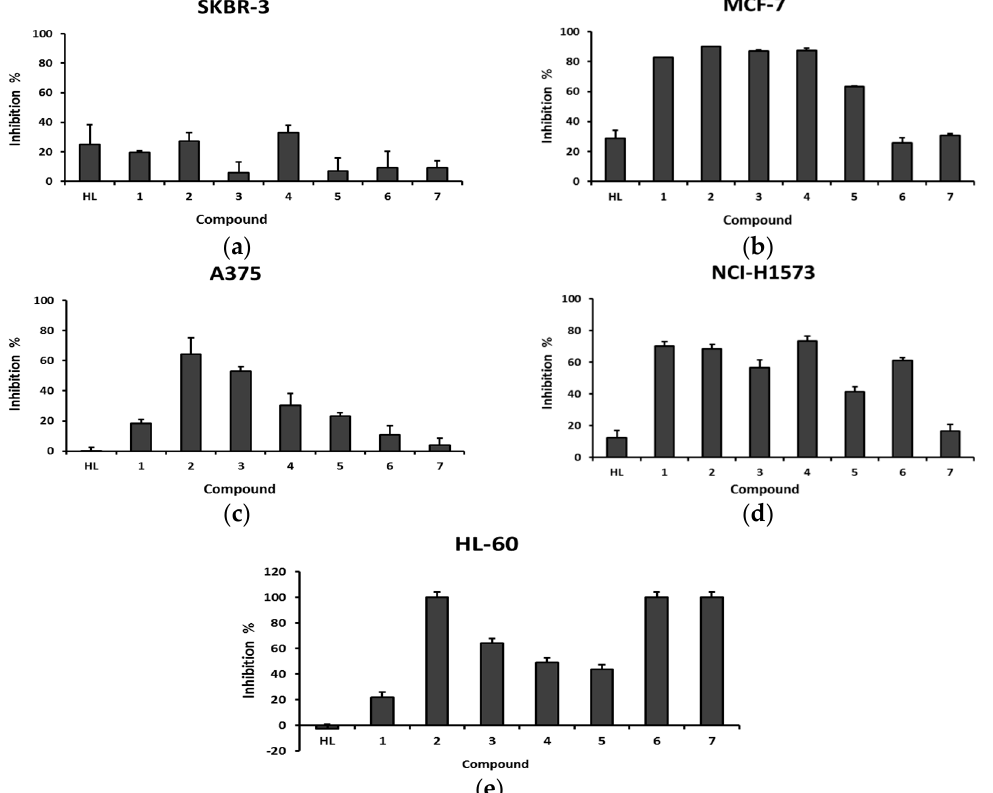
Figure 6. The effects of ligand HL and complexes 1 – 7 on SKBR-3, MCF-7, A375, NCI-H1573 and HL-60 cell proliferation. ( a ) Inhibition of cell proliferation on SKBR-3 human breast cancer cell line; ( b ) Inhibition of cell proliferation on MCF-7 human breast cancer cell line; ( c ) Inhibition of cell proliferation on A375 melanoma cell line; ( d ) Inhibition of cell proliferation on NCI-H1573 lung adenocarcinoma cell line; ( e ) Inhibition of cell proliferation on human leukemia HL-60 cells after exposure to 10 µM of tested compounds.